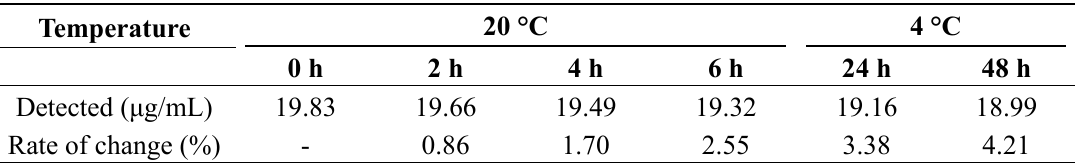
Table 2. Stability of NCE in perfusion